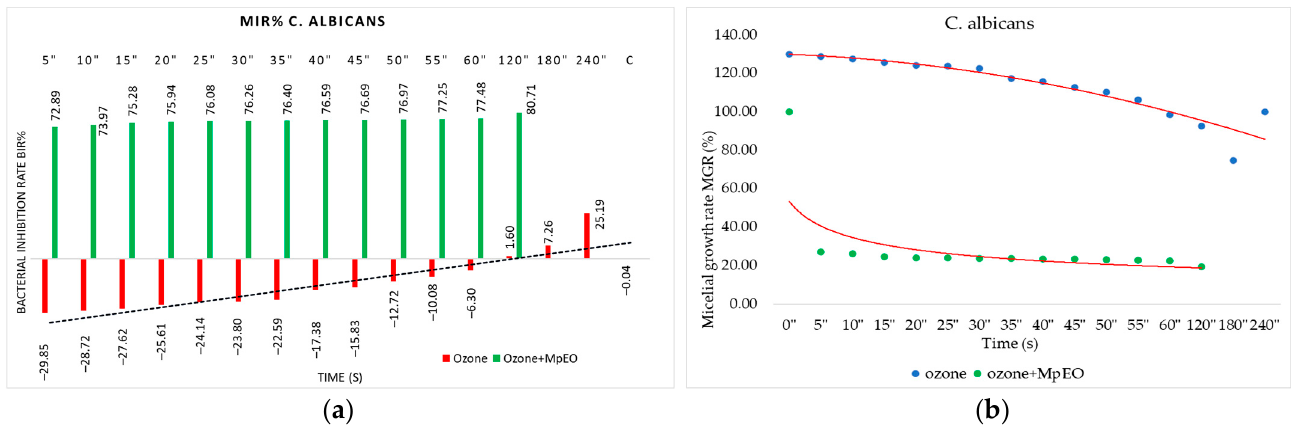
Figure 6. Ozone and ozone+MpEO antimicrobial activity tested on C. albicans at different time exposures expressed in seconds ( ″ ). ( a ) Results expressed as MIR%; ( b ) results expressed as BGR%.